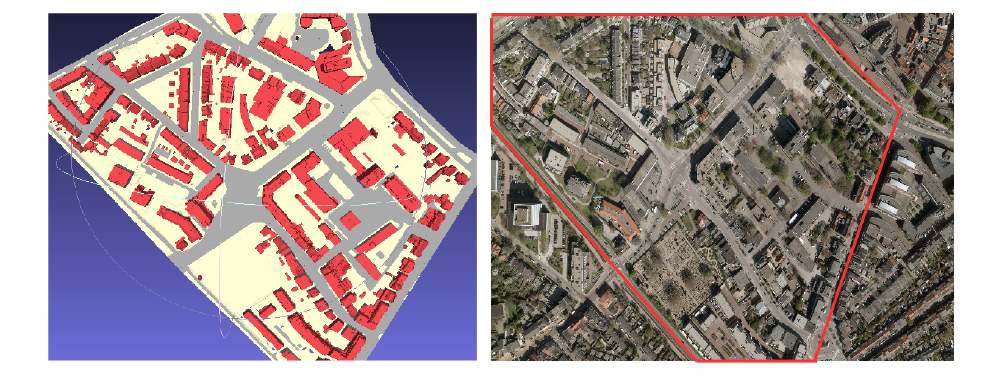
Figure 1. The 3D city models of Amersfoort with 200,000 triangles is created by using a hydrological map and AHN dataset around 2009 . The corresponding area of the aerial image in 2010 is shown in the red polygon areas. The different colors in the 3D model show different classes of